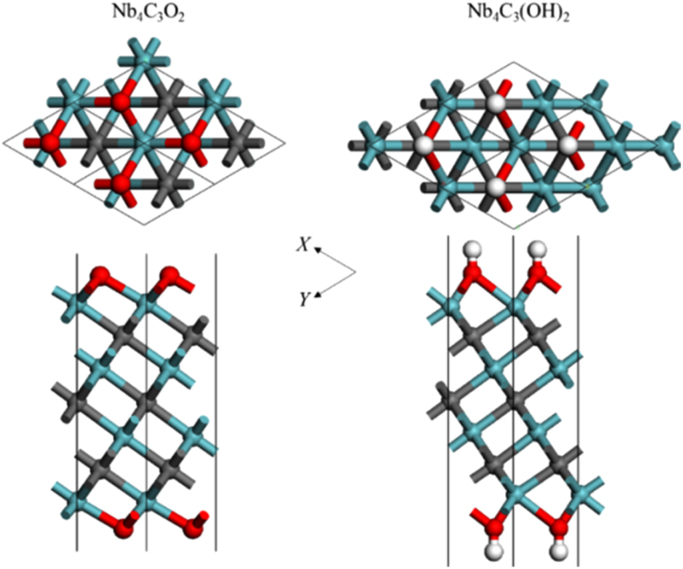
Top views and side views from the X direction of the optimal structures of Nb4C3O2 and Nb4C3(OH)2. The atoms represented by different color balls are the same as in Fig. 2.